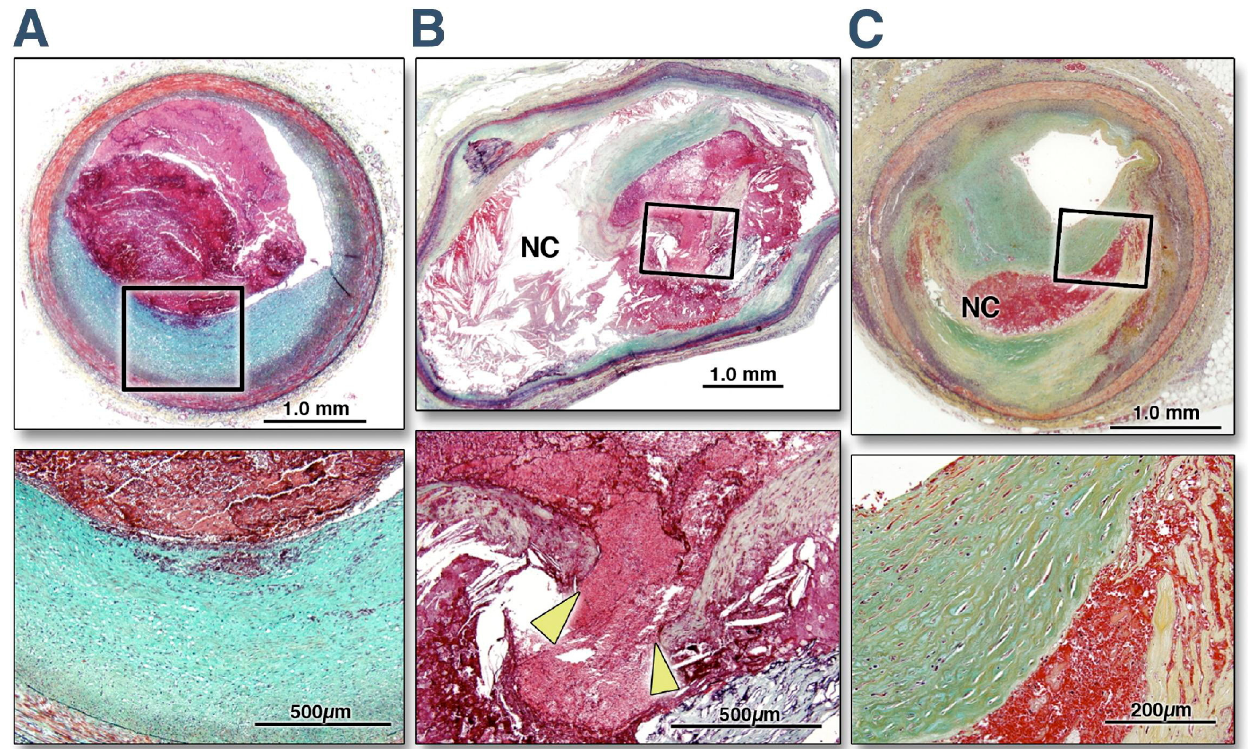
Figure 1. Histomorphological Characteristics of plaque erosion, plaque rupture, and a stable plaque. The top three photos report the cross-sectional area of a culprit lesion displaying a plaque erosion in a patient with acute coronary syndrome ( A ), a culprit lesion displaying a plaque disruption in a patient with acute coronary syndrome ( B ), and a stable unrelated plaque from a non-culprit site in another patient dying from sudden cardiac death ( C ). The boxed areas in the top panels are magnified in